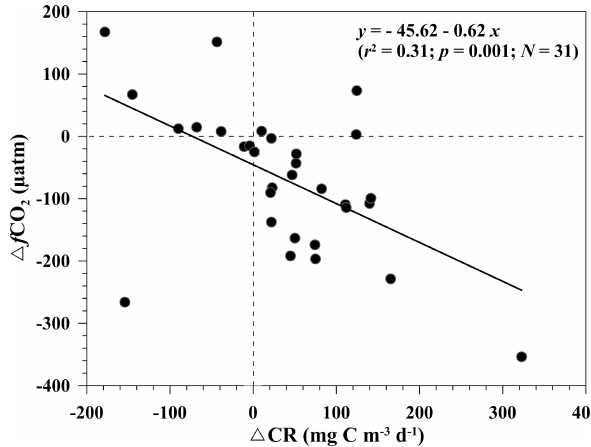
Figure 7. Differences ( (cid:49)) between 2009 and 2010 in f CO 2 (µatm) and plankton community respiration (CR; mgCm − 3 d − 1 ) in the surface water at the same station. For reference, the vertical and hor- izontal dashed lines represent interannual differences of zero (i.e., (cid:49) =